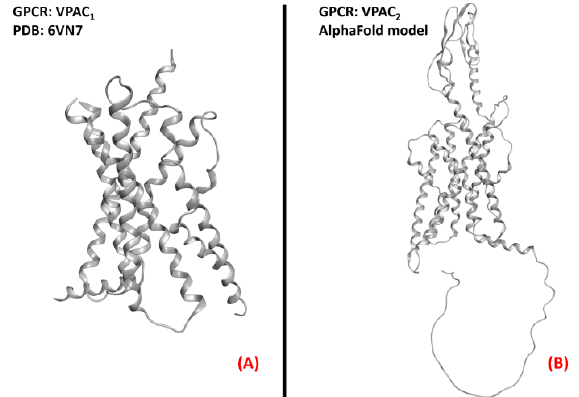
Figure 23. Structure of the receptors ( A ) VPAC 1 (sourced from the Protein Data Bank, PDB code: 6VN7 [155], method: cryo-EM, resolution: 3.20 Å ), and ( B ) VPAC 2 (with no experimentally resolved structure available, the model sourced from the AlphaFold database is presented). The images were created and rendered with MOE.